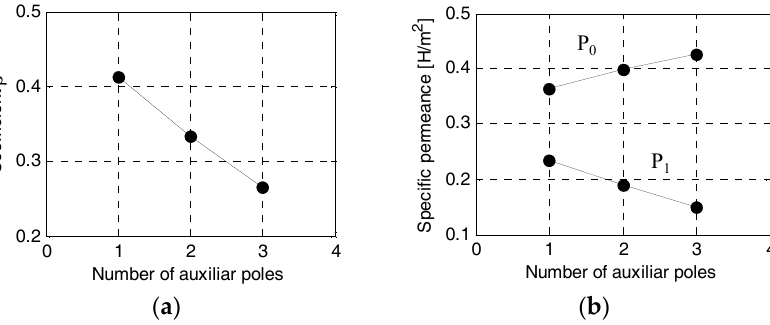
Figure 3. Variation of β and specific permeance with the auxiliary poles. ( a ) β ; ( b ) Specific permeance P 0 and P 1 .